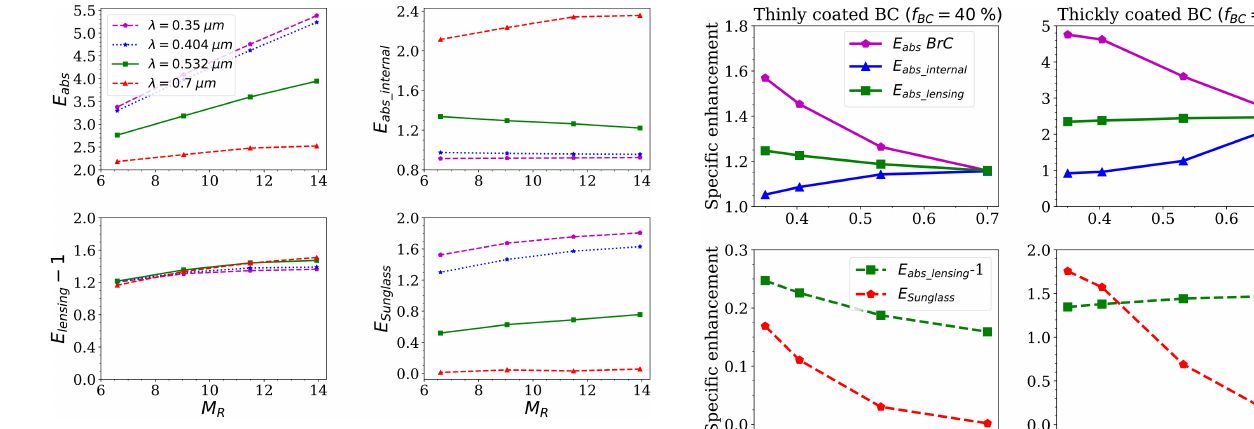
Figure 11. E abs and E abs_lensing of thickly coated BC with BrC coatings varying with M R ( r g = 0 . 06µm, σ g = 1 . 5).